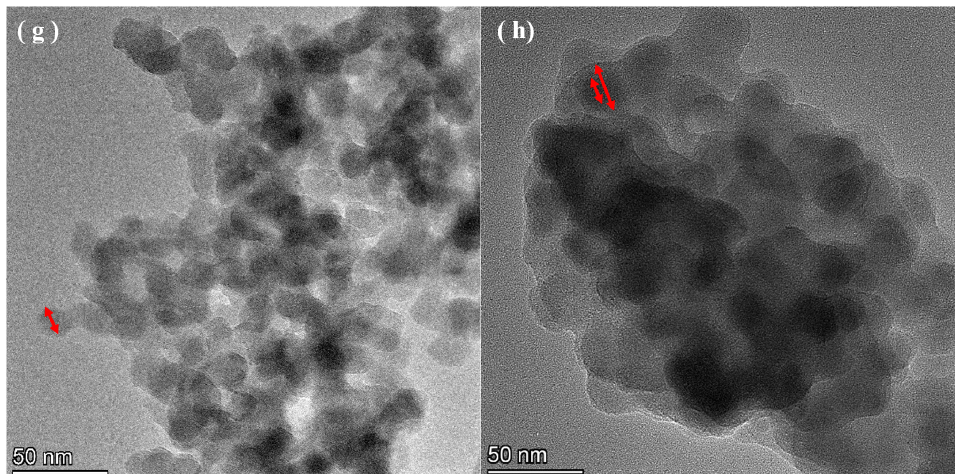
Figure 1. Characterizations of adsorbent: ( a ) FTIR spectra of SiO 2 , SiO 2 –Br and SiO 2 –g–PBMA–b–PDMAEMA. ( b ) TGA curves of SiO 2 , SiO 2 –Br and SiO 2 –g–PBMA–b–PDMAEMA. ( c ) 1 H NMR spectrum of SiO 2 –g–PBMA–b–PDMAEMA. ( d ) GPC curve of SiO 2 –g–PBMA–b–PDMAEMA. ( e ) XRD